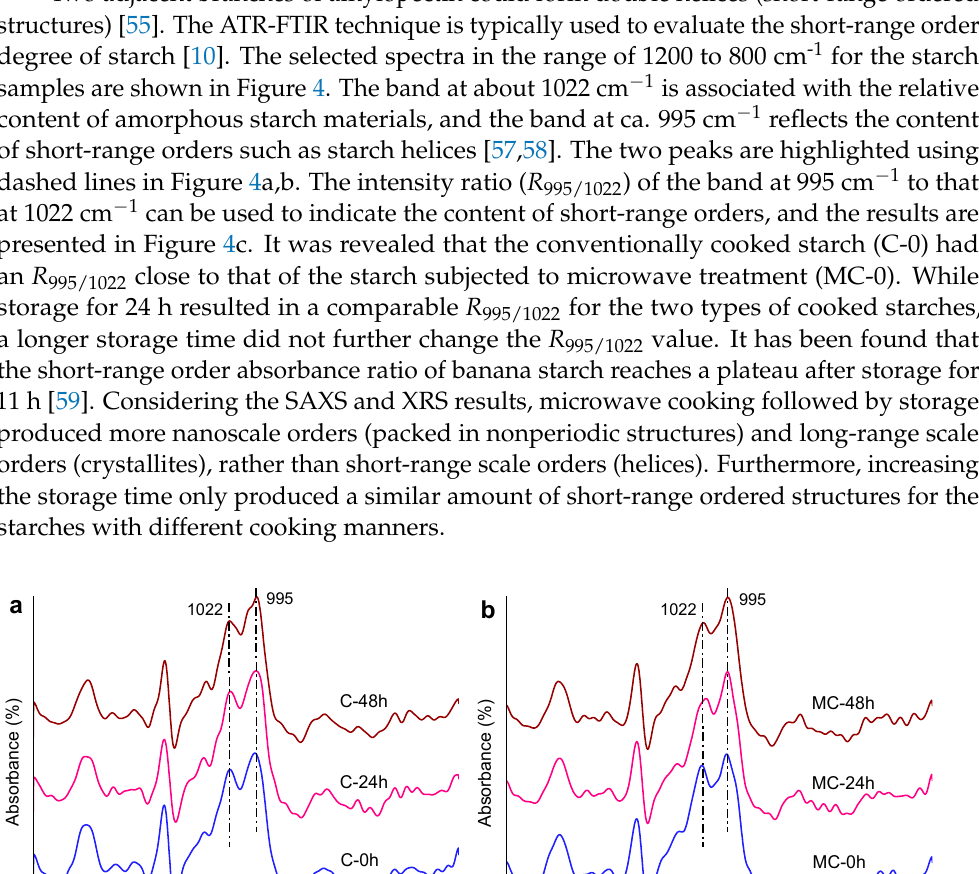
Figure 3. XRD diffractograms of conventionally (C) ( a ) and microwave-cooked (MC) ( b ) starches with different storage times (0, 24, or 48 h).